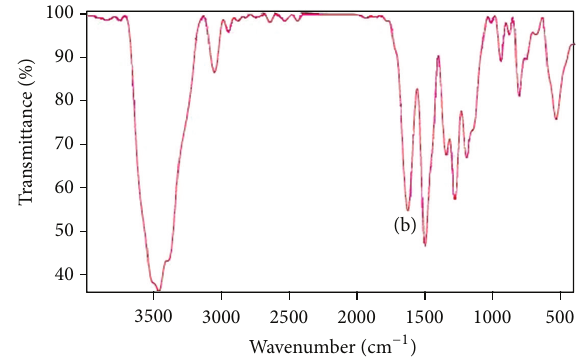
Figure 9: IR spectrum of D301R resin of loading Ni 2+